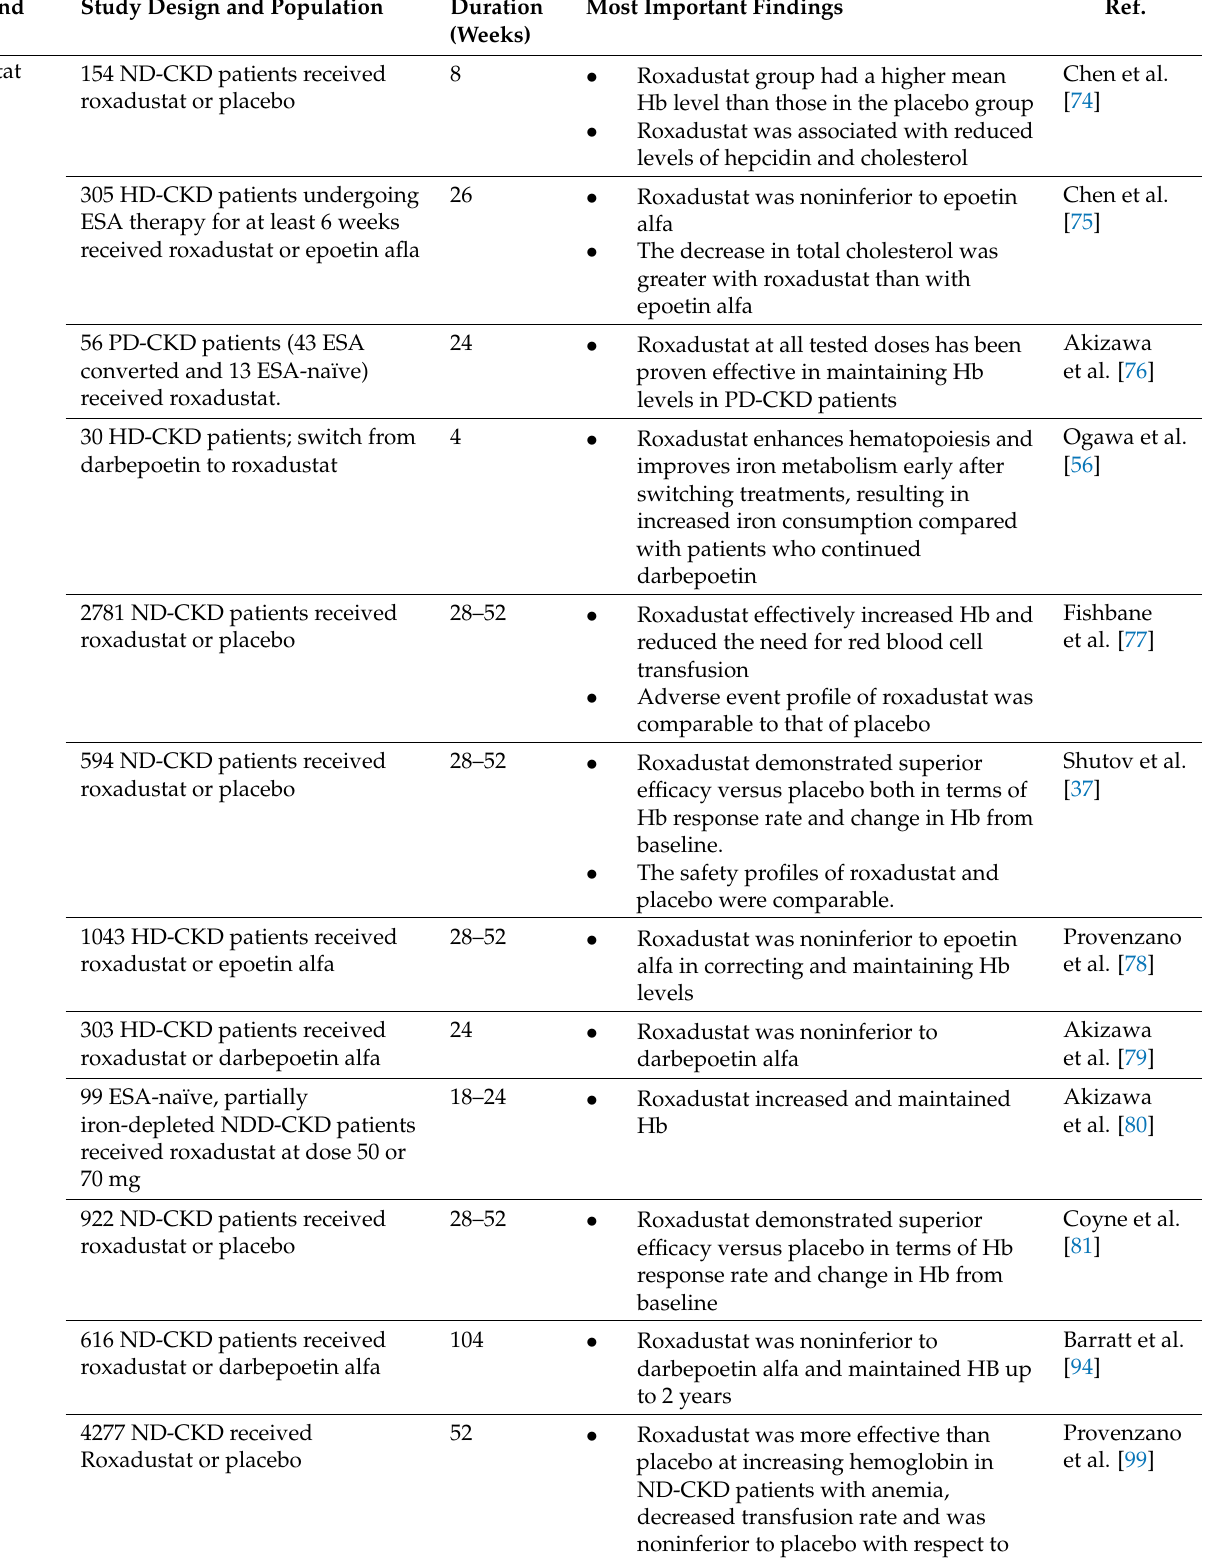
Table 2. The main results of selected phase 3 studies of HIF-PIHs in CKD